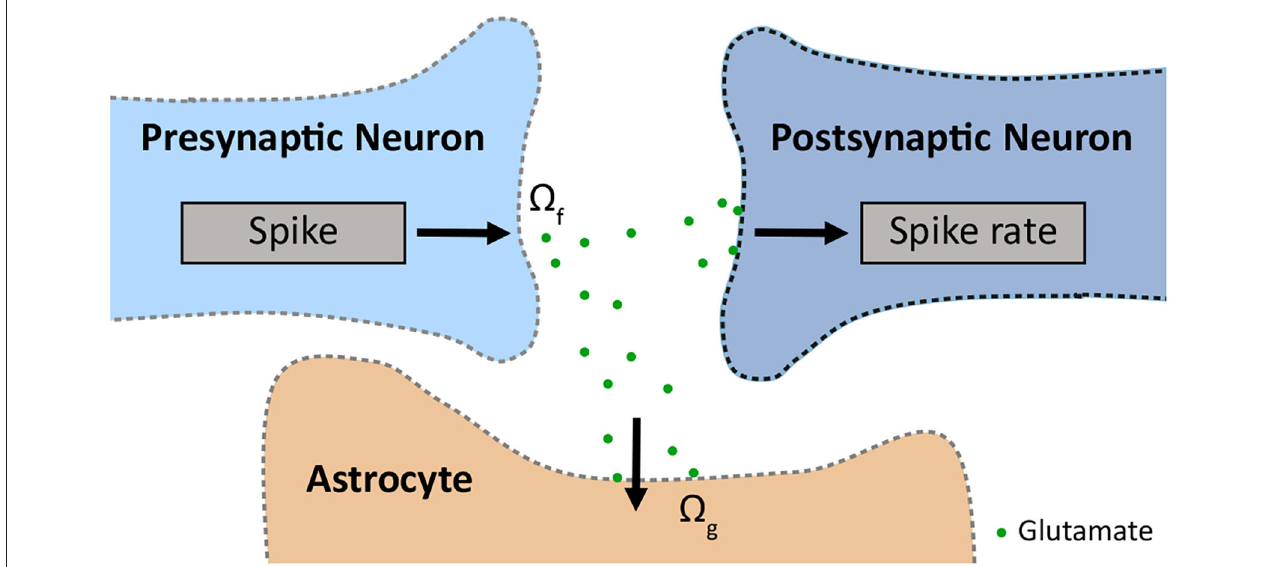
FIGURE 1 | Schematic of the tripartite synapse, which consists of a pre- and a postsynapse and an astrocyte, modelled with INEXA (Lenk et al., 2020). The presynapse releases glutamate with release rate (cid:127) f . The glutamate is taken up by the astrocyte with uptake rate (cid:127) g .